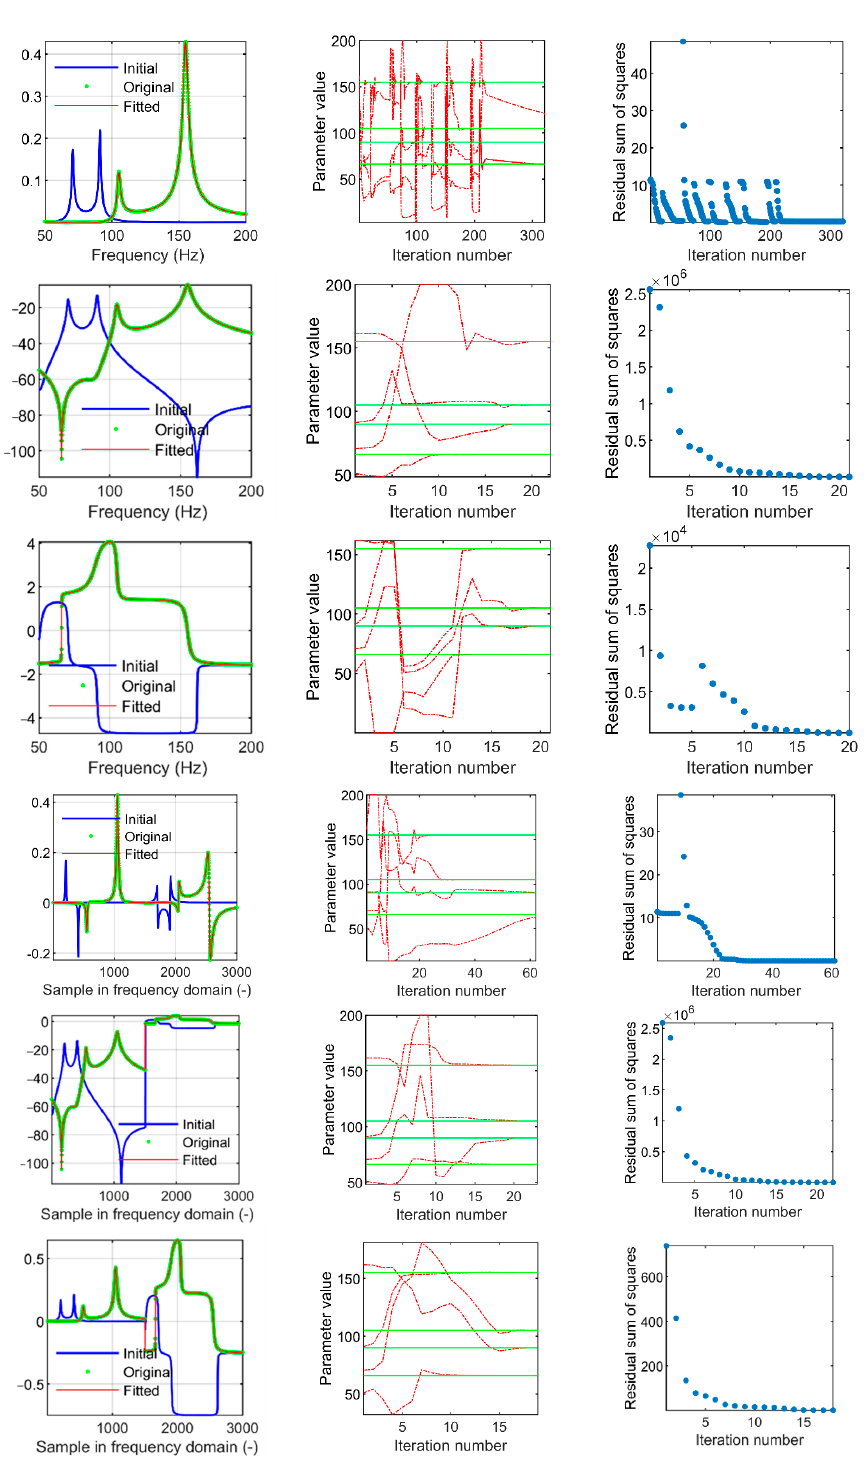
Figure 4. Identification results from synthetic data: ( left ) visualization of data representation with initial condition and best fit, ( middle ) convergence of the found values (red line) to true parameters (green line—resonant and anti-resonant frequencies), ( right ) change in residual sum of squares in each iteration. Representation from first to last row: Z abs , Z dB , Z arg , Z realimag , Z dBarg , Z absarg